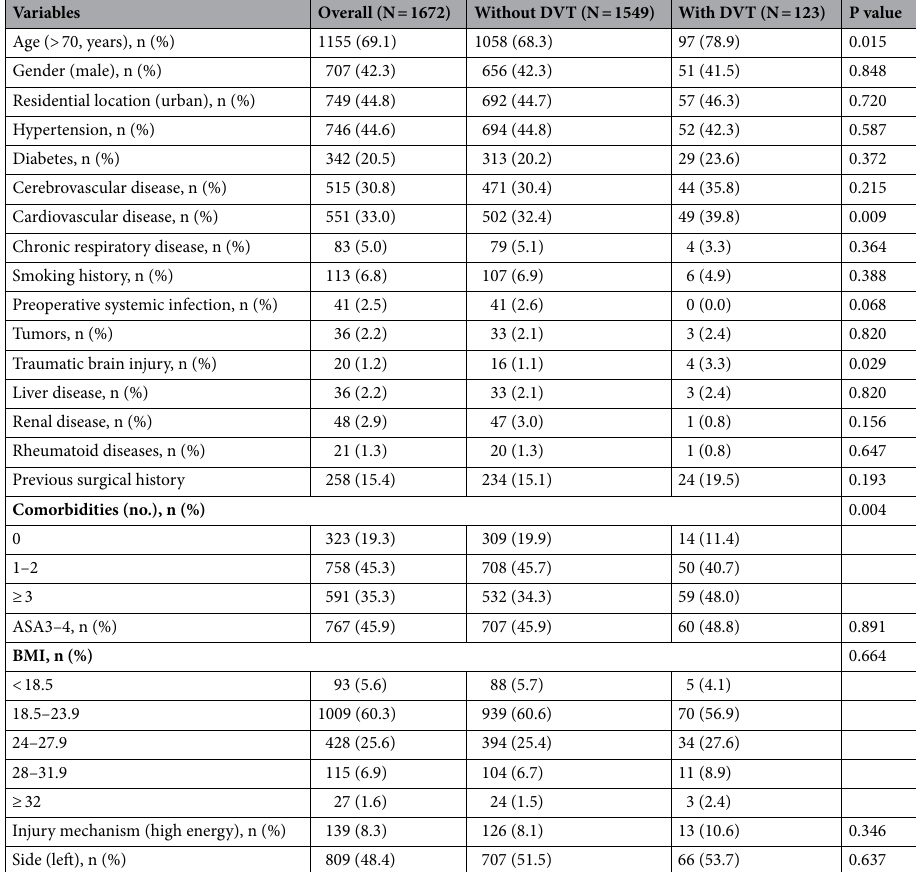
Table 2. Comparison of demographics and fracture characteristics between the two groups. ASA American Society of Anesthesiologists, BMI body mass index.